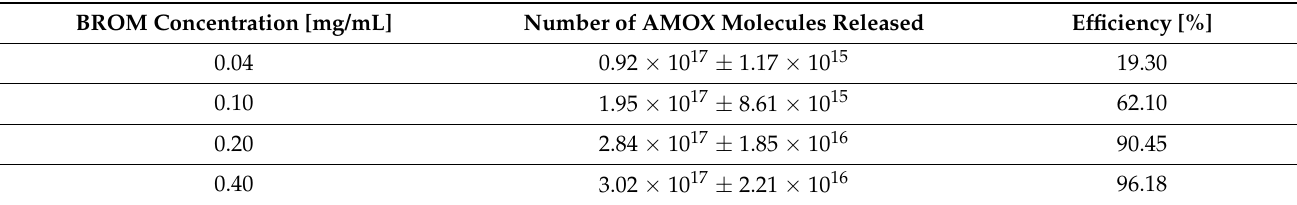
Table 2. The efficiency of the AMOX releasing (average values from four measurements) with BROM encapsulated in alginate by 24 h. The initial number of AMOX molecules attached to 1 mg of GO was 3.14 × 10 17 ± 4.78 × 10 16 . BROM Concentration